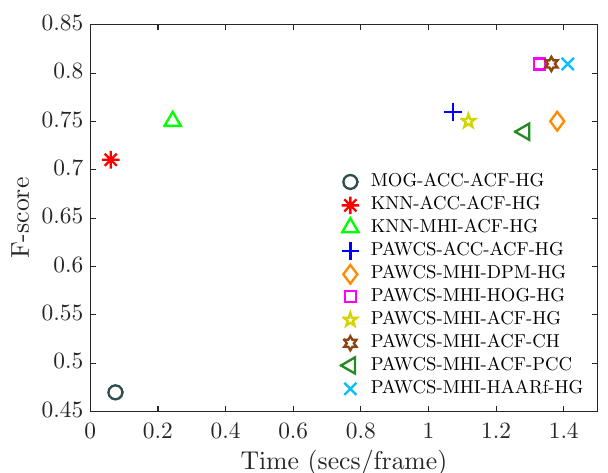
Figure 16. Relation between performance (F-score) and computational time (seconds per frame) of a selection of relevant configurations.